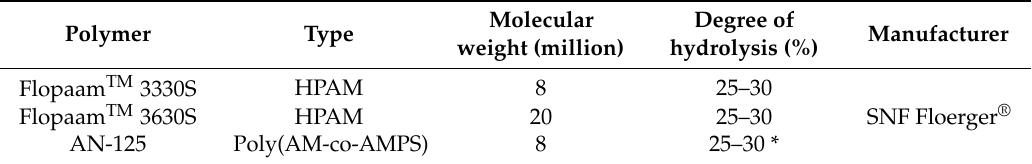
Table 1. Polymers tested in this study.